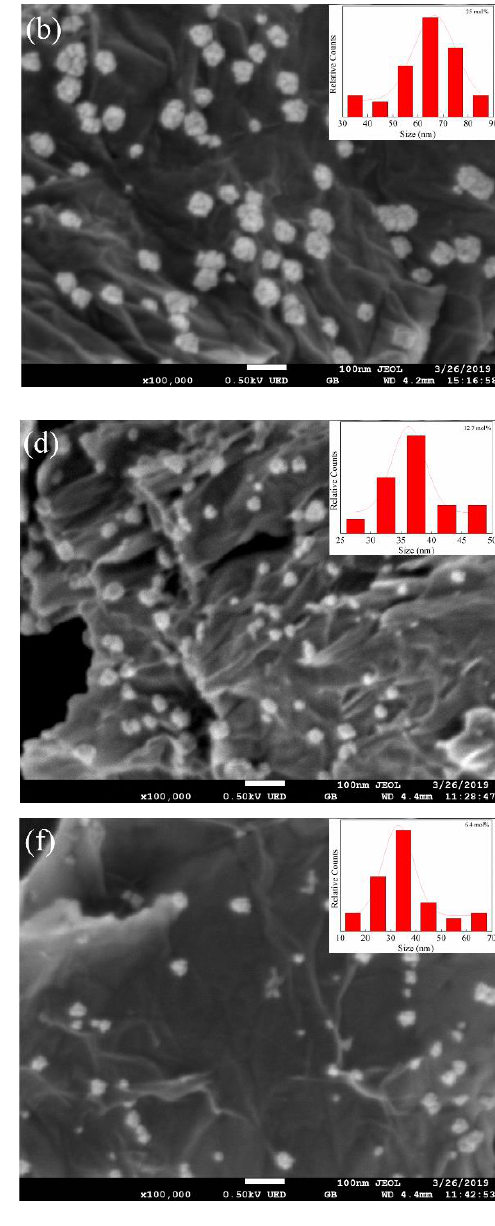
Figure 5. SEM images of Ni-GNSs samples with ( a ) 50, ( b ) 25, ( c ) 17, ( d ) 12.7, ( e ) 9.3, ( f ) 6.4 mol % theoretical Ni loadings.